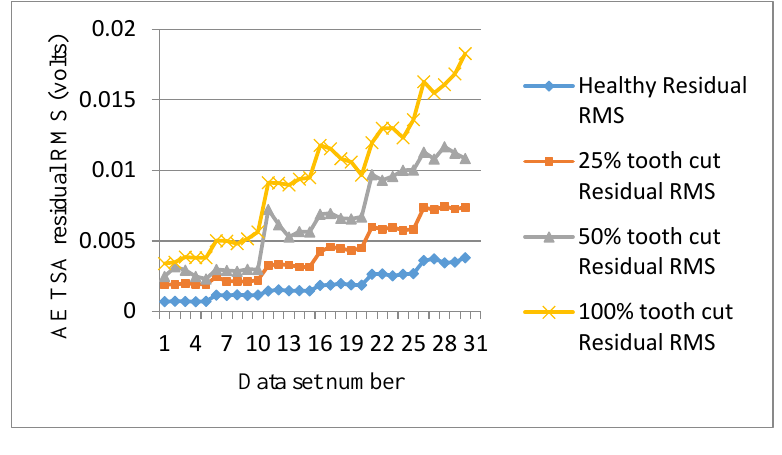
Figure 8. RMS of AE residual signals.